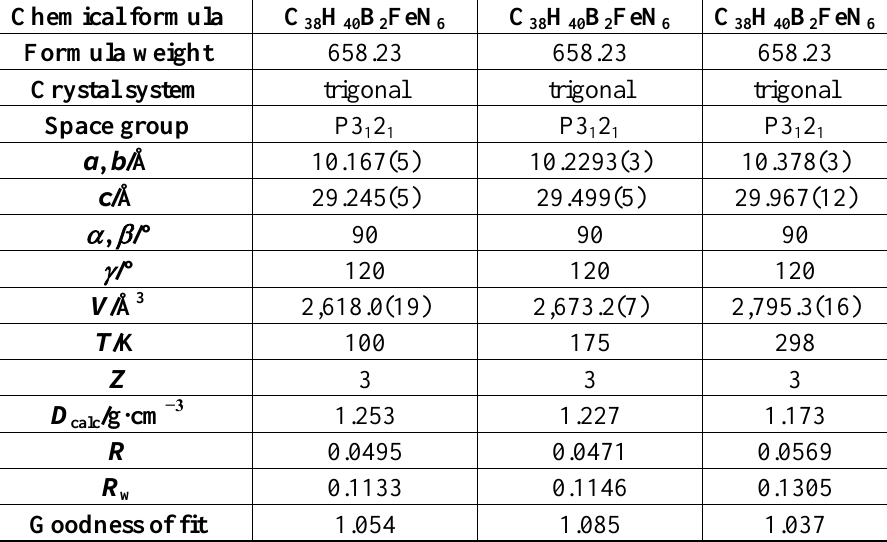
Table 1. Selected crystal data for spiral